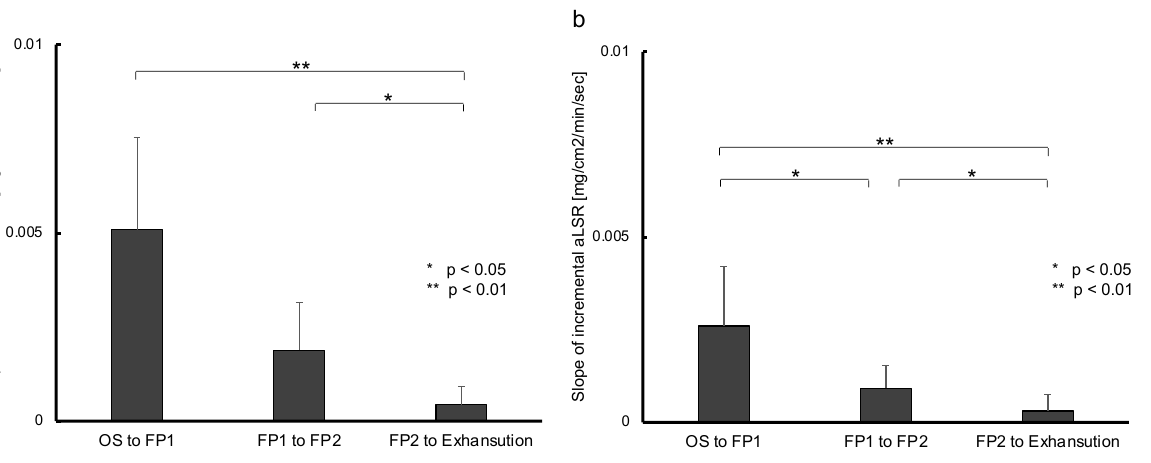
Figure 2. Change in the slope of incremental local sweat rate in the duration segmented by two inflection points during pedaling exercise. This figure shows the change in the slope of incremental local sweat rate from the onset of sweating to exhaustion in constant-load exercise. Each duration was divided into two inflection points of sweat rate over time. ( a ): Significantly gradual decreasing sweat rate measured at the forehead was detected over time using the Friedman test ( p < 0.01, partial η 2 = 0.79) and the Bonferroni method as the post-hoc test (OS to FP1 vs. FP1 to FP2, p = 0.07; FP1 to FP2 vs. FP2 to exhaustion, p = 0.014). ( b ): Significantly gradual decreasing sweat rate measured at the upper arm was detected over time using repeated-ANOVA ( p < 0.01, η 2 = 1.00) and the Bonferroni method (OS to FP1 vs. FP1 to FP2, p = 0.014; FP1 to FP2 vs. FP2 to exhaustion, p = 0.014). OS, onset of sweating; FP1, first flexion point; FP2, second flexion point; hLSR, local sweat rate measured at forehead; aLSR, local sweat rate measured at upper arm. Table 2. Difference in local sweat rate during constant-load exercise until exhaustion.